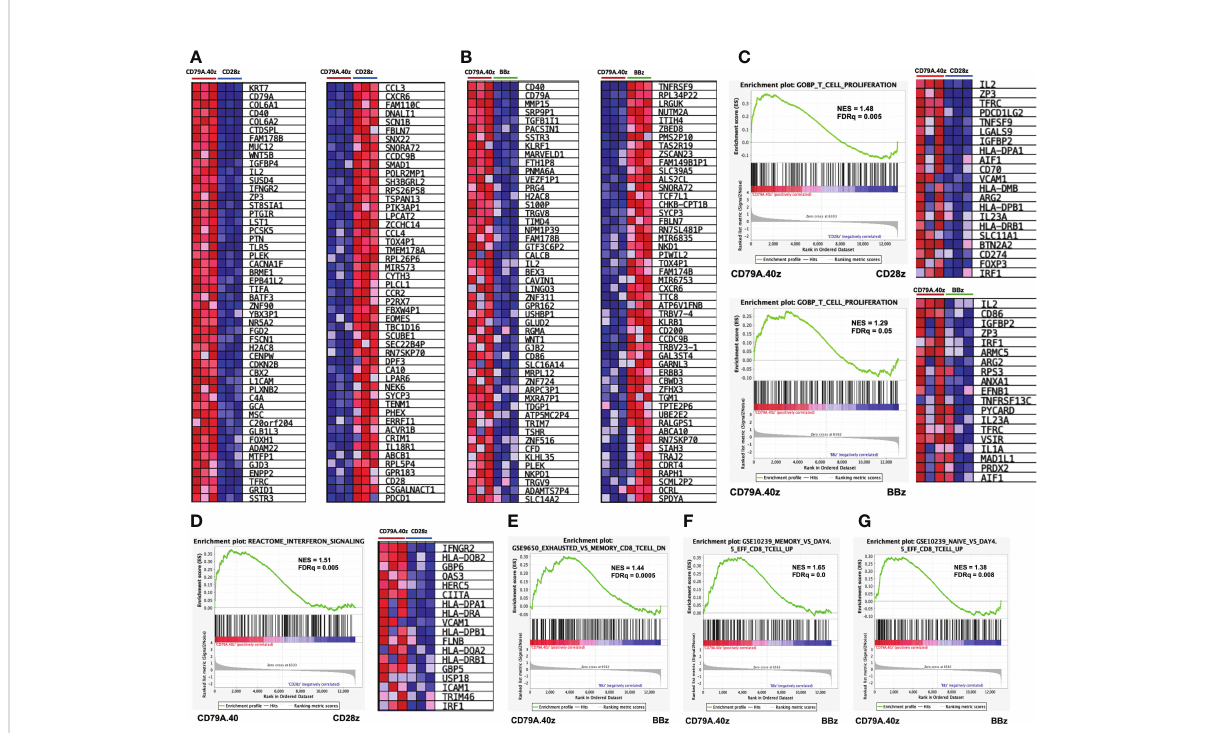
FIGURE 4 Gene set enrichment analysis of CD19.79A.40z CAR-T cells following antigen stimulation. (A, B) Heatmap of the top 50 up- (left) or down- (right) regulated genes differentially expressed by either (A) CD19.79A.40z CAR-T cells vs. CD19.28z CAR-T cells or (B) CD19.79A.40z CAR-T cells vs. CD19.BBz CAR-T cells. The colors re fl ect expression values of normalized counts, which range from red (high expression), pink (moderate expression), light blue (low expression), to dark blue (lowest expression). (C) Representative GSEA results of enriched GO-BP T-cell proliferation in CD79A.40z CAR-T cells vs. CD19.28z CAR-T cells (upper) and CD79A.40z CAR-T cells vs. CD19.BBz CAR-T cells (lower) with heatmap of the top up-regulated genes (right). (D) GSEA of signi fi cantly enriched in interferon signaling pathway of CD79A.40z CAR-T cells vs. CD19.28z CAR-T cells, using the REACTOME database with heatmap of the top up-regulated genes (right). (E) GSEA enriched in down- regulation of exhausted-relative to memory CD8 T-cell related gene in CD19.79A.40z CAR-T cells vs. CD19.BBz CAR-T cells. (F, G) GSEA up- regulated in (F) memory-relative to effector-related genes and (G) naïve-relative to effector-related genes of CD19.79A.40z CAR-T cells vs. CD19.BBz CAR-T cells. The upper part of each GSEA plot displays the enrichment score, whereas the lower part displays the ranked list metric of the gene set. The ranked gene list is shown in the middle: red indicates up-regulation; blue indicates down-regulation; and the black vertical line indicates the gene set. FDR q-value cutoff ≤ 0.25, Nominal p-value ≤